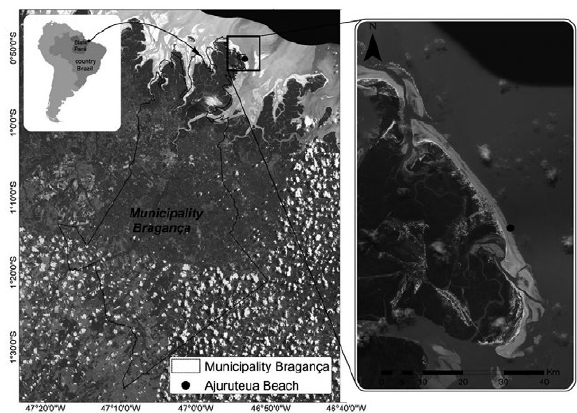
Fig. 1. – Map of the study area, Ajuruteua sandy beach, Bragança, Pará,